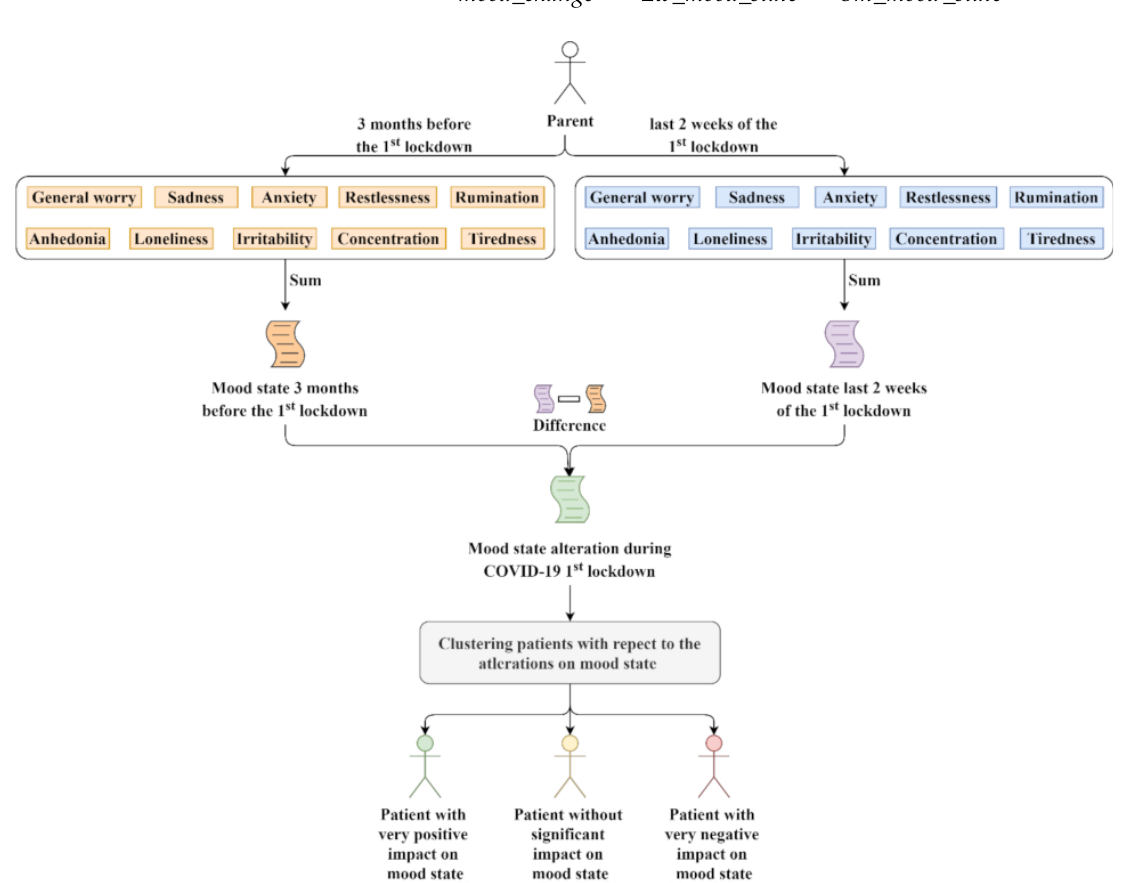
Figure 2. Clustering